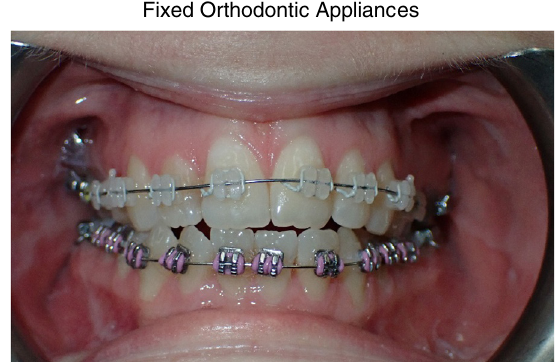
Figure 8. Fixed orthodontic